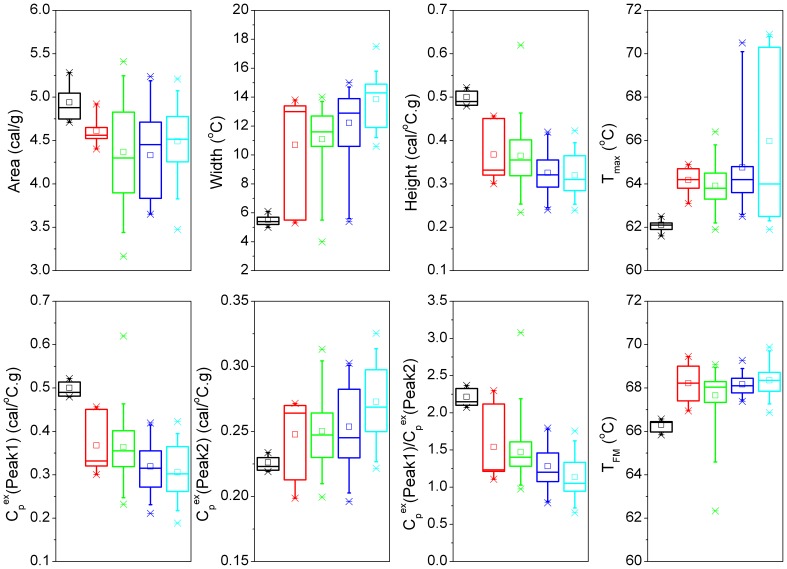
Box charts showing thermogram shape and feature parameters for each clinical group.Trends in thermogram parameters are observed with increasing disease burden from healthy controls (black); LSIL (red); HSIL (green); early stage IC [FIGO Stage I] (blue); and advanced IC [FIGO Stage II-IV] (cyan). Increased width with concomitant decreased height reflects the change in profile shape with disease progression seen in Figure 1A. TFM, the first moment temperature corresponding to the geometric center of the thermogram, provided a measure of this shape redistribution. TFM proved superior to Tmax, the temperature of the peak maximum, as a discriminatory metric for advanced IC where large distribution of Tmax values was correlated with significant variability in the heights of the major profile peaks. Profile width and the ratio of the major transition amplitudes, Cp
ex (Peak 1) and Cp
ex (Peak 2), provided the best metrics for discrimination of clinical status. Summary of statistical analyses of these parameters is shown by Tables 1 and 2. In each box chart the median value is indicated by the horizontal line within the box while the 25th and 75th percentiles are indicated by the lower and upper box edge, respectively. The mean value is indicated by the square within the box. The upper and lower “whiskers” define the 95th and 5th percentiles, respectively. The 99th and 1st percentiles are shown by the crossed symbols and the horizontal lines denoted the minimum and maximum of the data set.